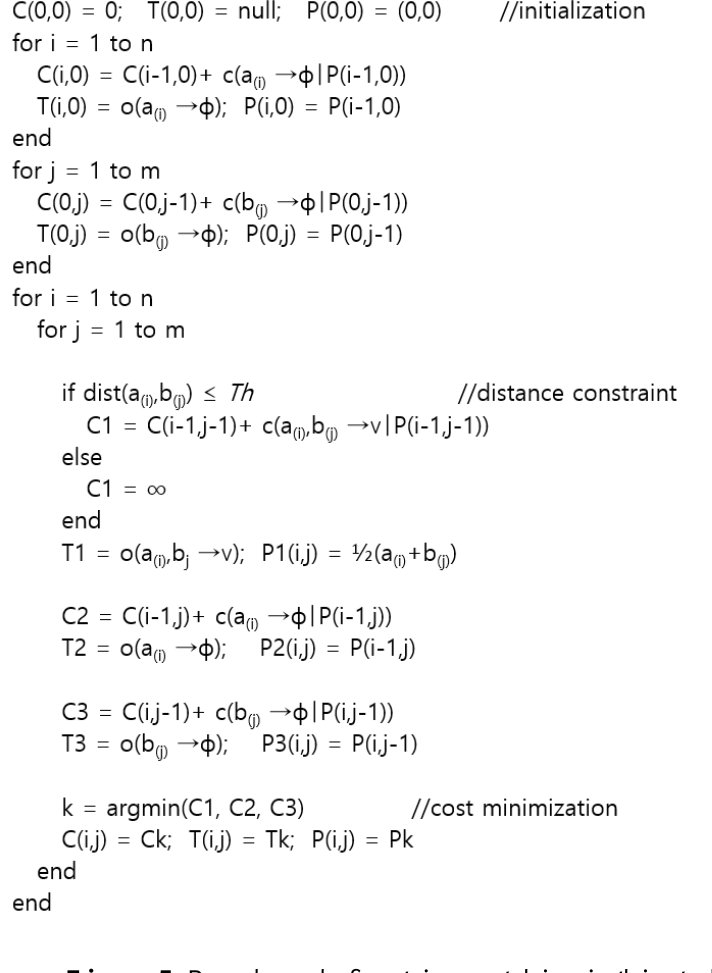
Figure 5. Pseudo code for string matching in this